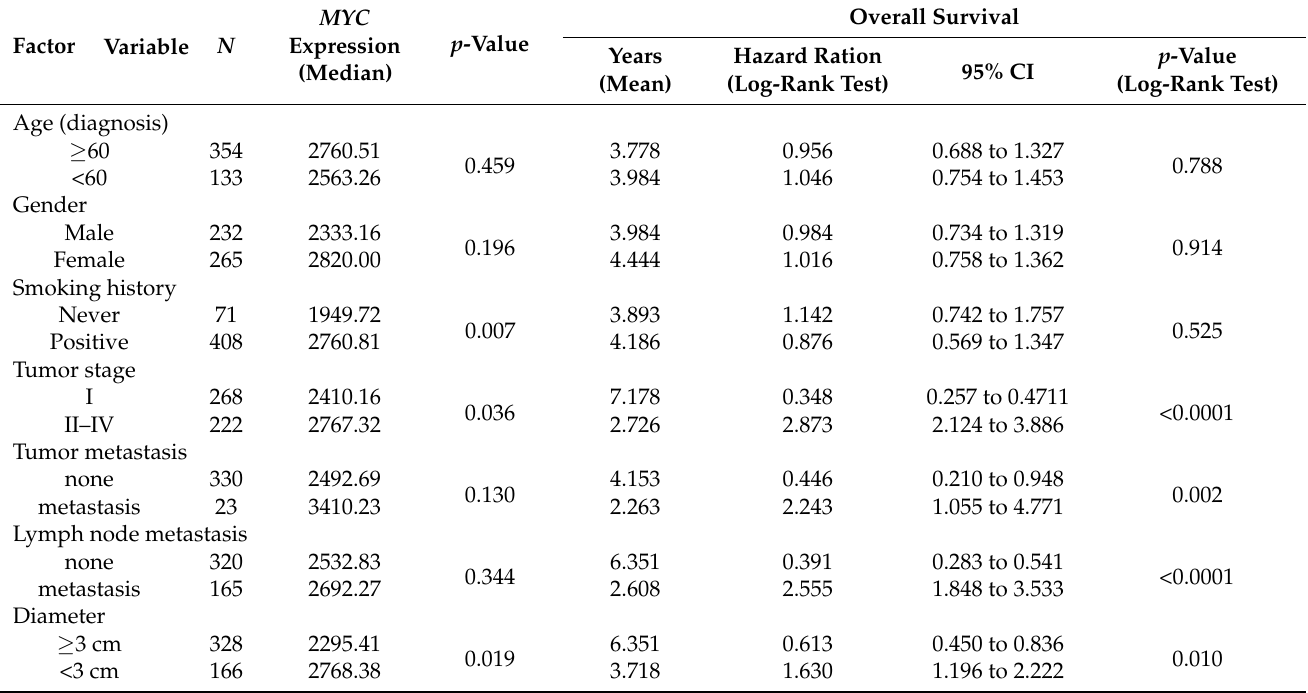
Table 1. Univariate analysis of the overall survival in lung adenocarcinoma (LUAD) patients based on clinical feature stratification and the relationship between MYC